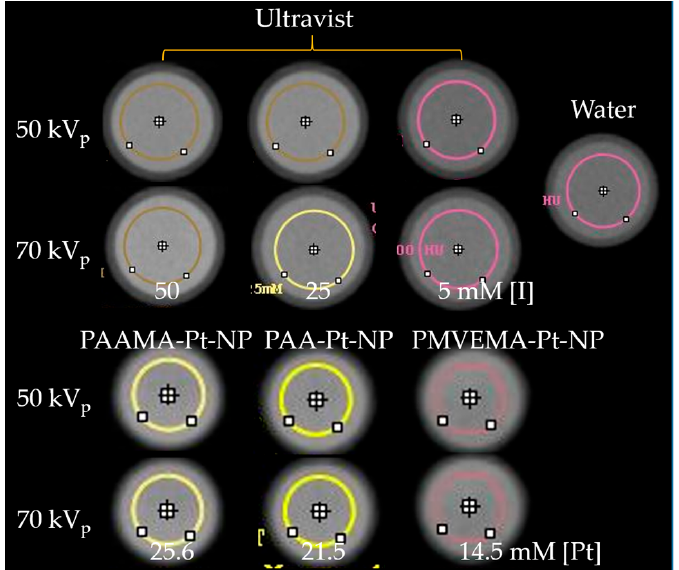
Figure 8. X-ray phantom images of polymer-coated Pt-NPs in aqueous media and Ultravist (X-ray source voltages, 50 and 70 kV p